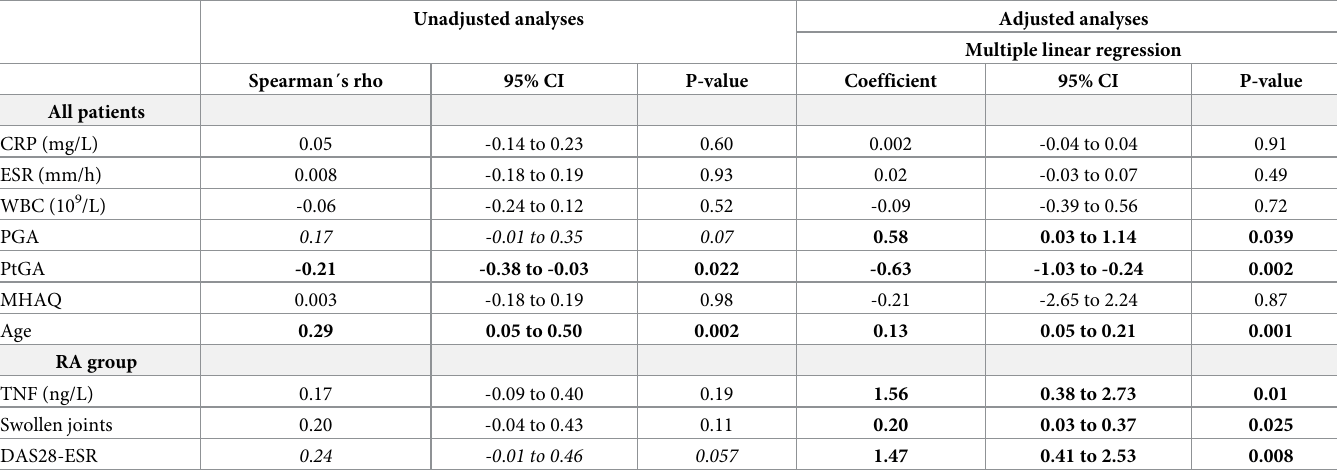
Table 2. Associations between hsTnT levels and selected variables at baseline. Unadjusted analyses Adjusted analyses